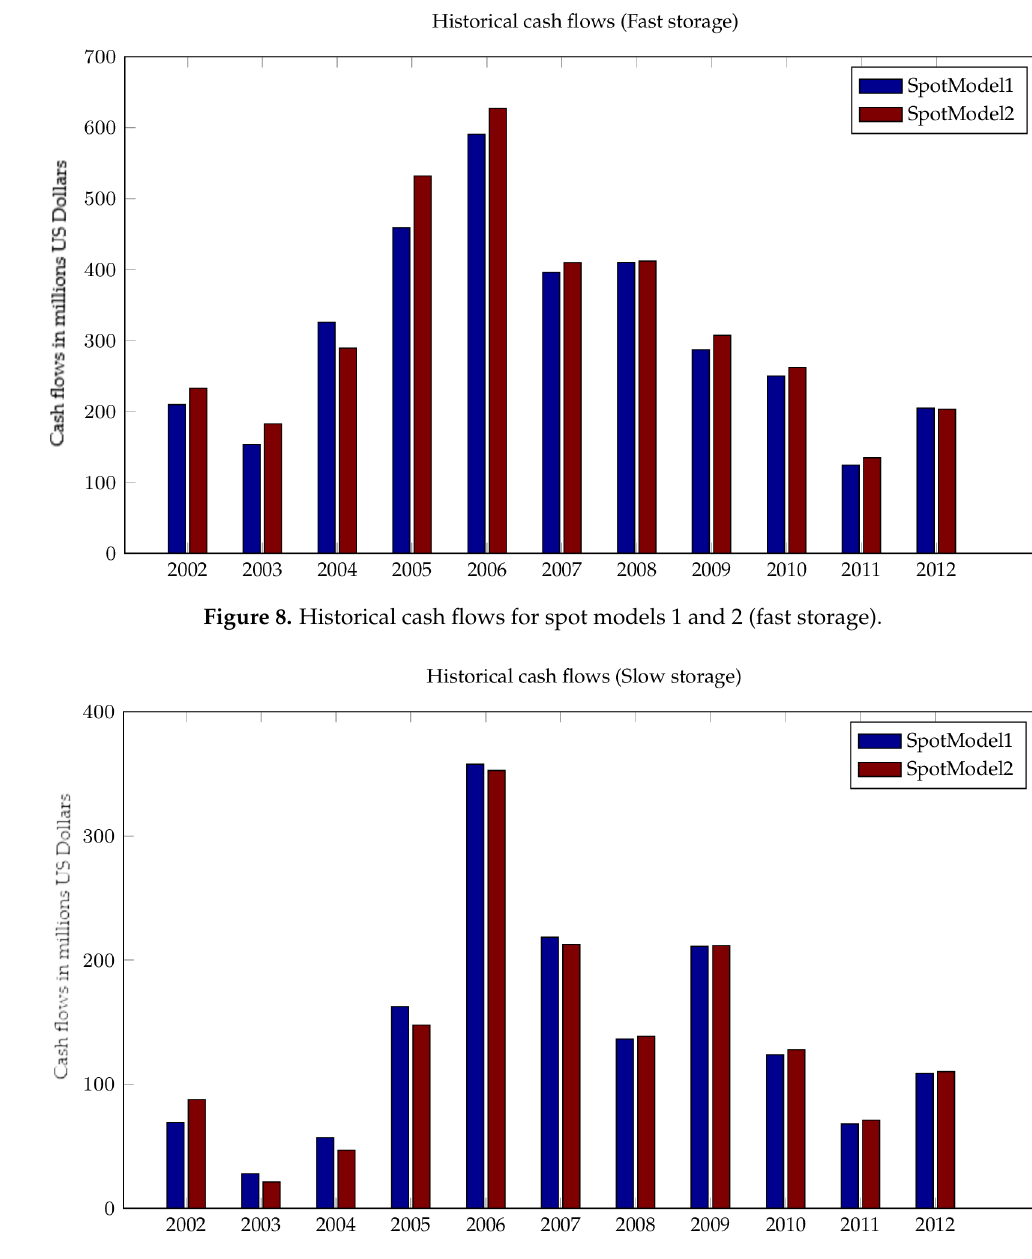
Figure 9. Historical cash flows for spot models 1 and 2 (slow